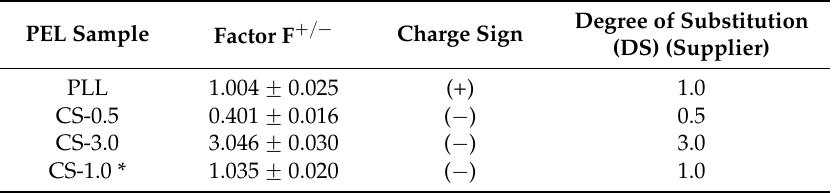
Table 1. Charge factors and signs of 0.002 M polyelectrolyte (PEL)